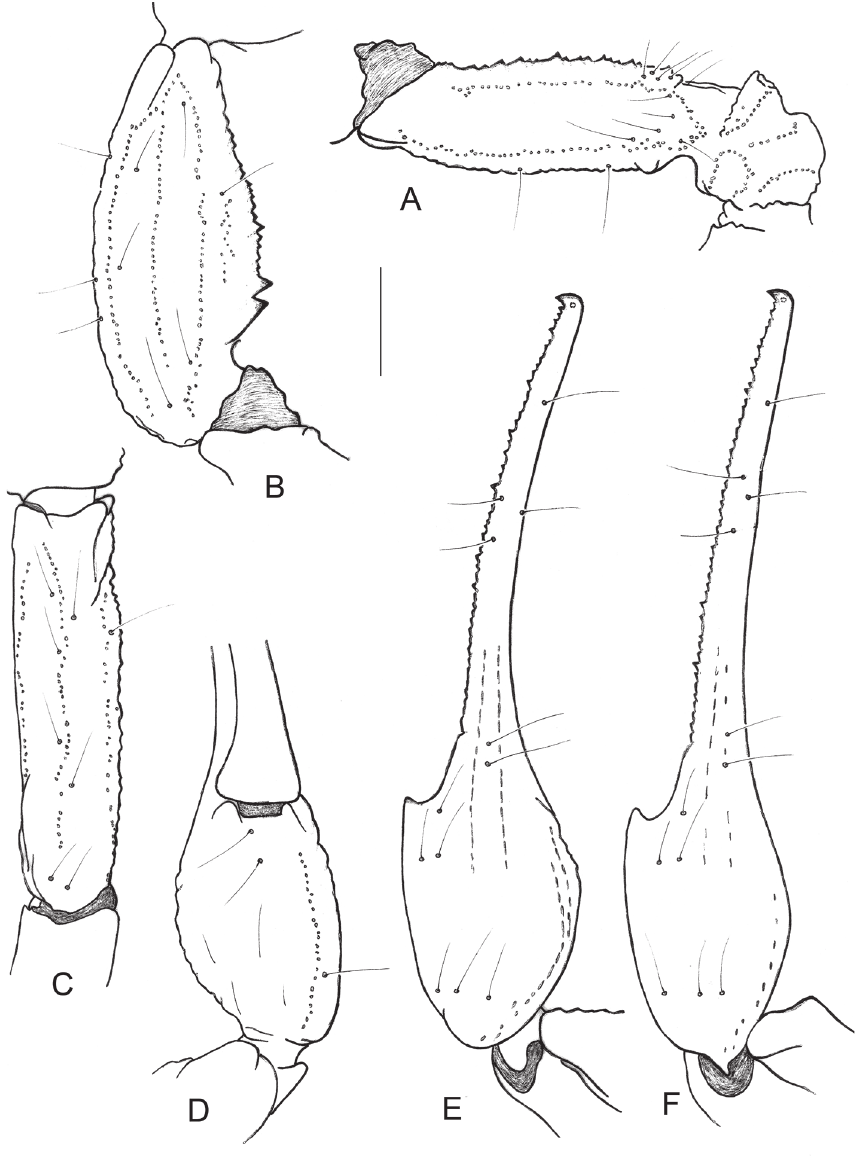
Figure 6. Physoctonus amazonicus sp. n., female holotype. Trichobothrial pattern. A Femur, dorsal aspect B–C Patella, dorsal and external aspects D–E Chela, ventral and dorso-external aspects F Idem, Physocto- nus debilis , female from Caxias. Scale bar: 1